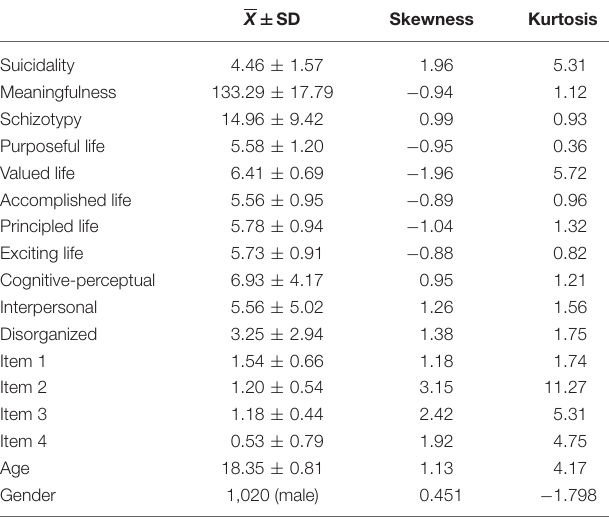
TABLE 1 | Descriptive characteristics of measured variables. TABLE 2 | Correlations among measured variables.